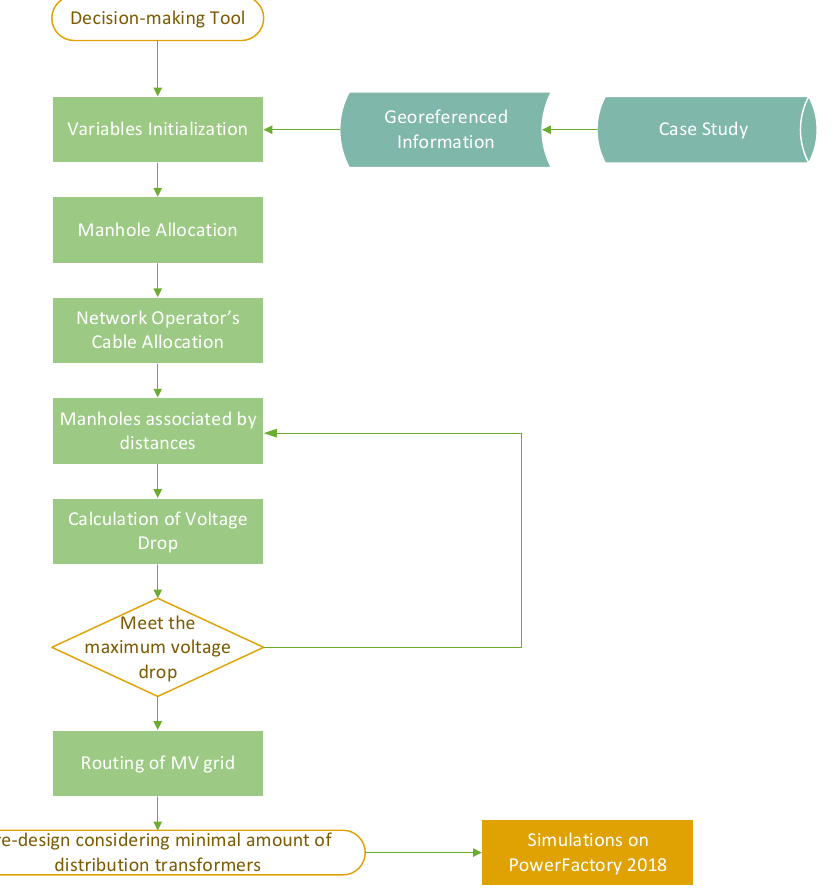
Figure 2. A proposed flowchart to determine a pre-design of a distribution network considering a minimal amount of